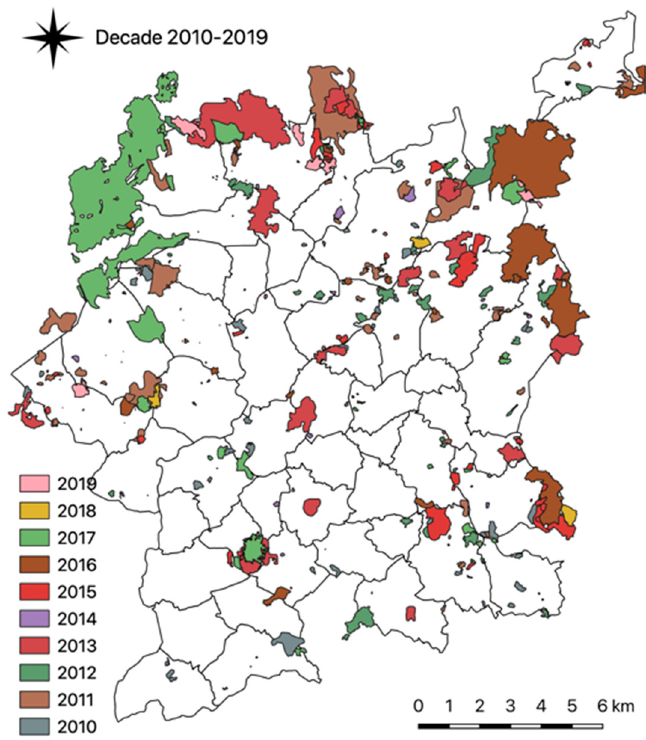
Figure 10. Rural fires occurred in Guimarães from 1970 to 2019 (adapted from data available at the ICNF website).